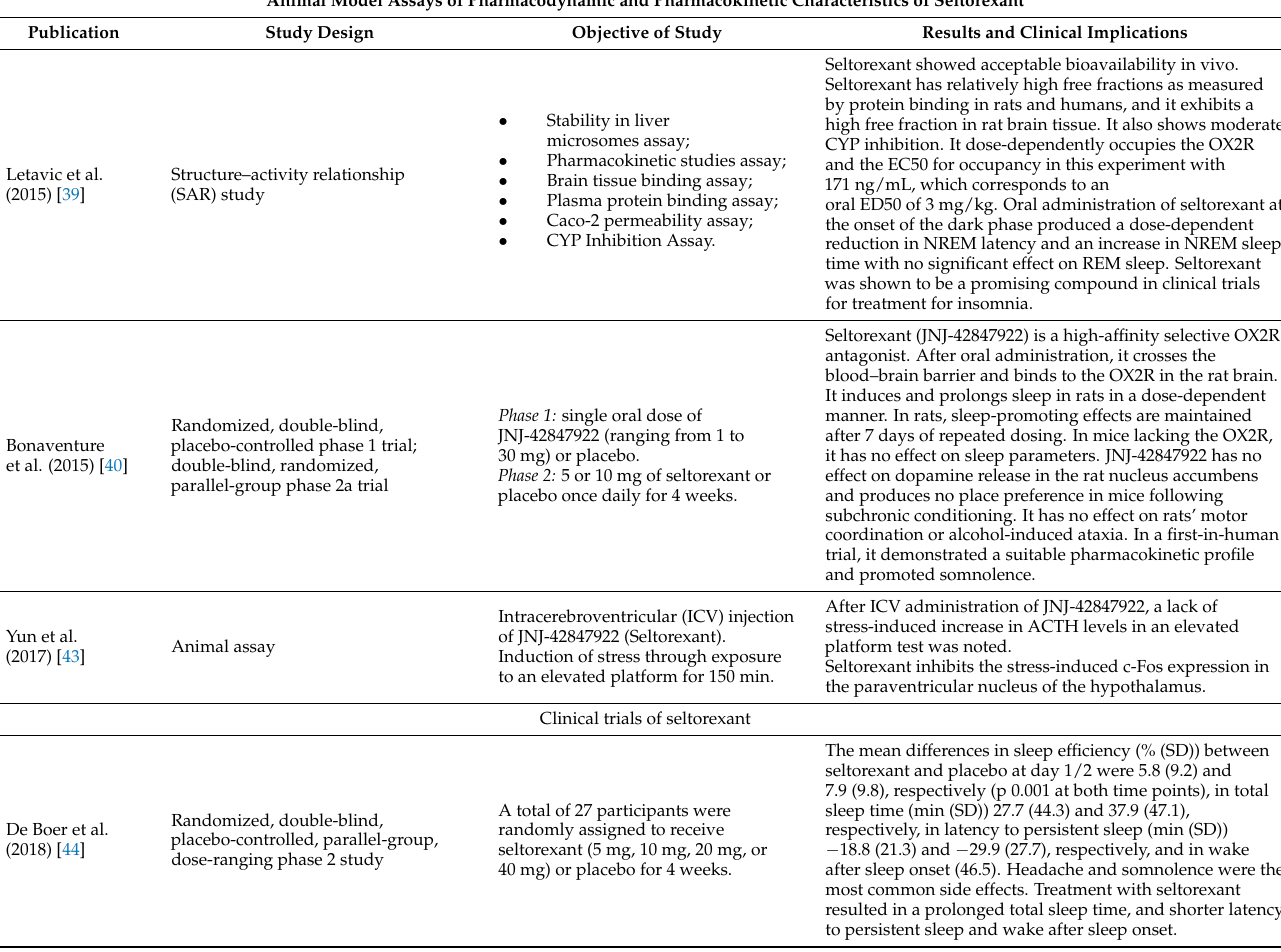
Table 2. Summary of preclinical studies and clinical trials, both in in vivo and animal models, performed in order to assess the pharmacodynamic and pharmacokinetic characteristics of seltorexant. Animal Model Assays of Pharmacodynamic and Pharmacokinetic Characteristics of